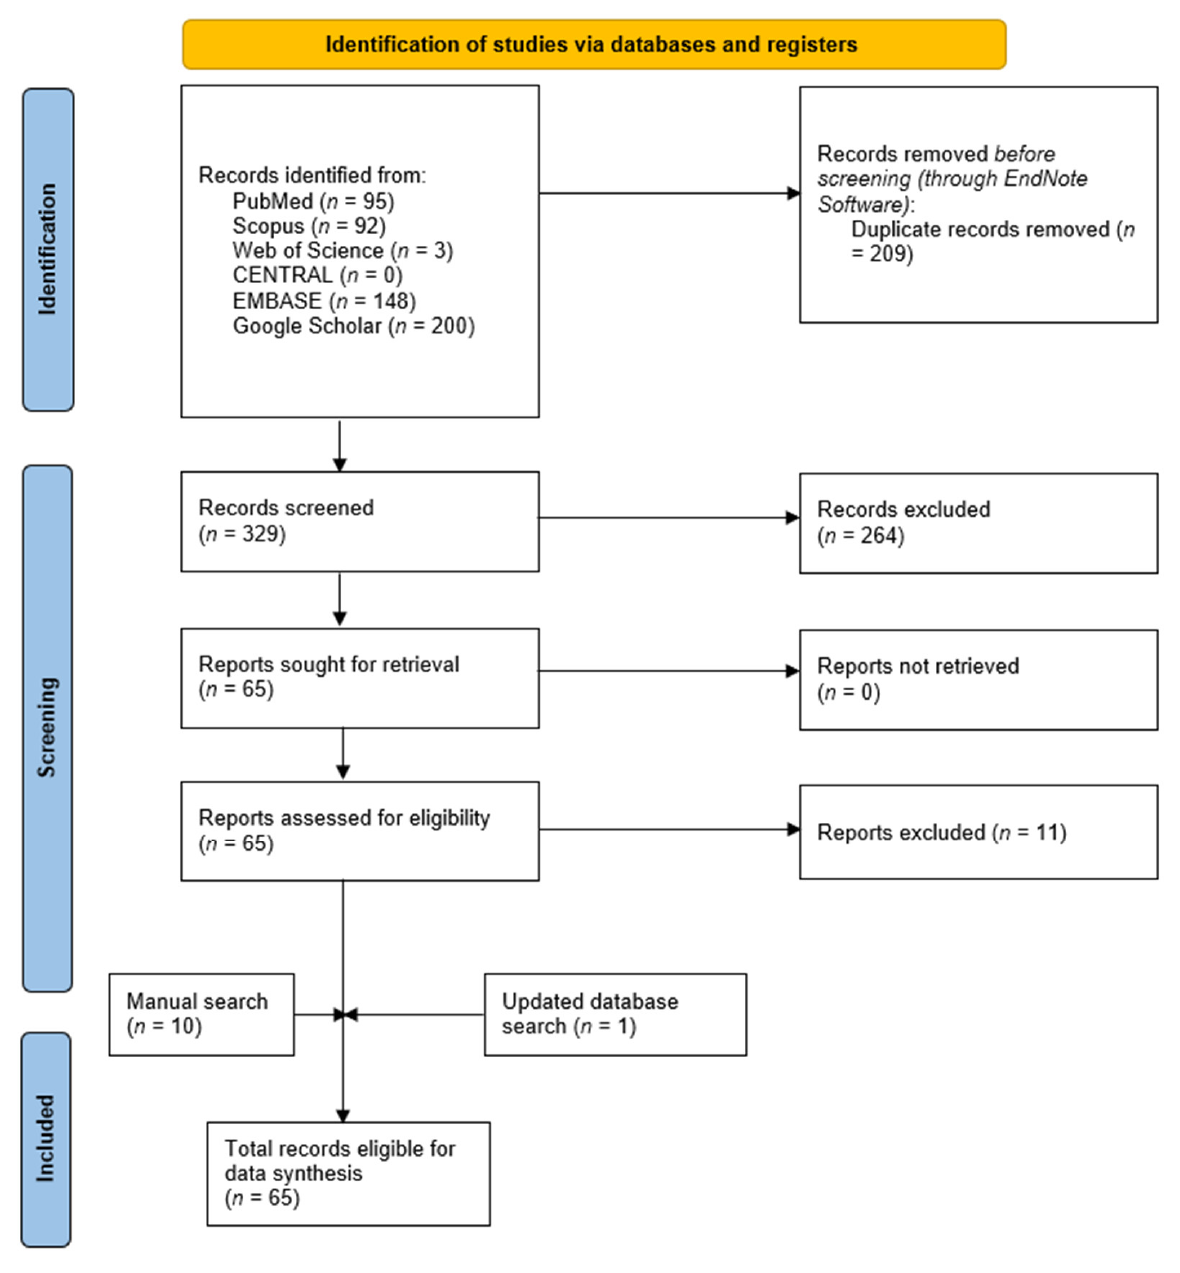
Figure 1. A PRISMA flow diagram showing the database search and screening results. Table 1. The baseline characteristics of studies reporting COVID-19 vaccine-associated uveitis